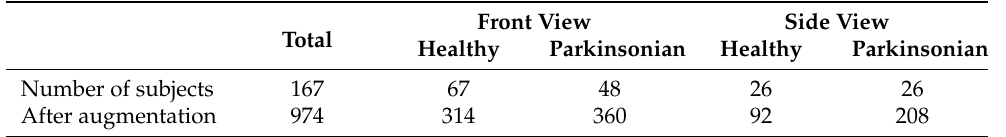
Table 2. Subject distribution in the dataset.